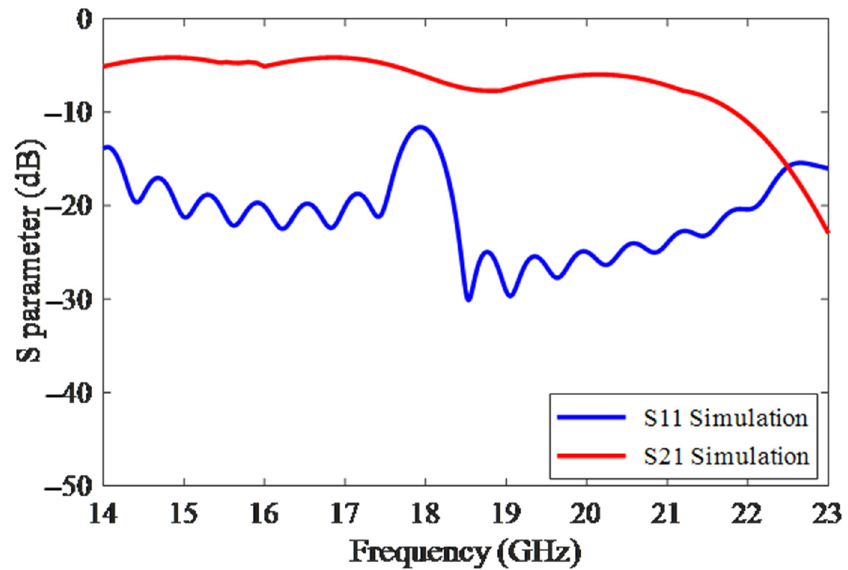
Figure 2. The simulated S parameters of SIW LWA.